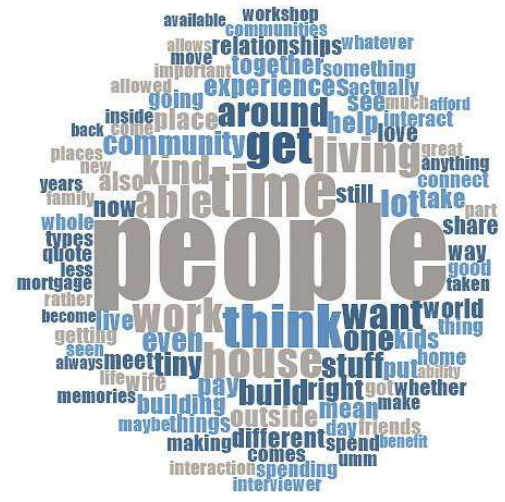
Figure 4. World cloud for Motivator 3.